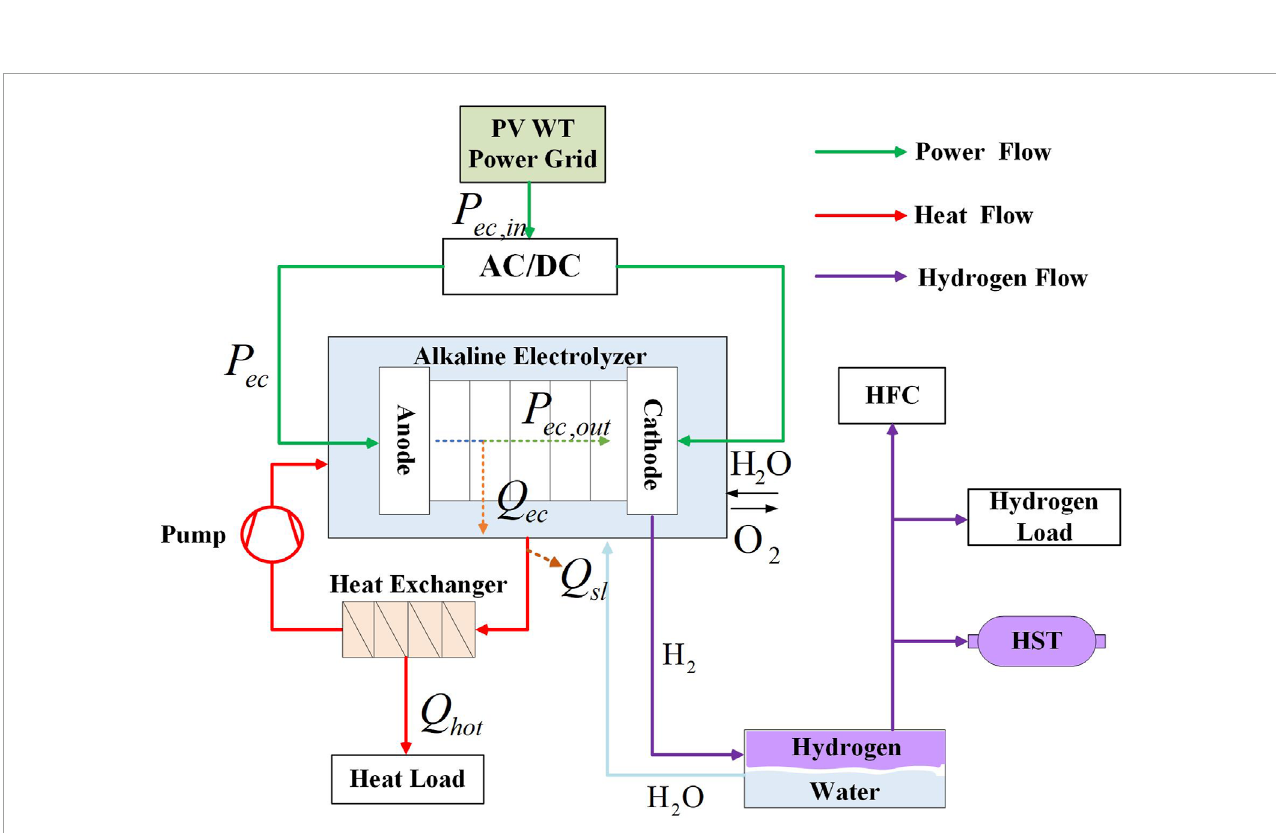
FIGURE 2 Diagram of refined utilization of